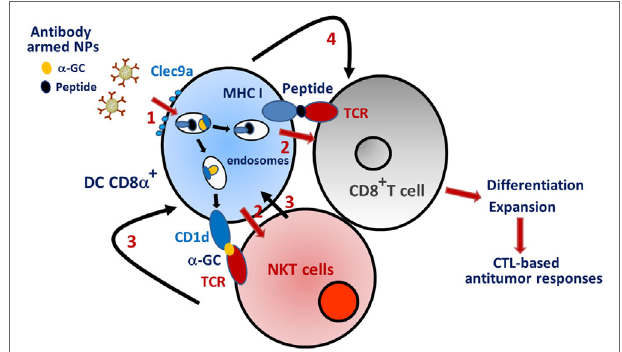
FiGURe 1 | Schematic “ménage à trois” between CD8 α + DC, natural killer T (NKT) cells, and naive CD8 + T cells. (1) Anti-Clec9a-armed nanoparticles that carry α -GalCer and tumor antigen are taken up by CD8 α + DC via the endocytic receptor Clec9a. (2) The active components are delivered in the endosomes and presented via MHC class I (peptide) and CD1d ( α -GalCer) to naïve CD8 + T cells and NKT cells, respectively. (3) In response to TCR triggering, NKT cells activate the maturation of CD8 α + dendritic cells (DCs) through cytokines and costimulatory (CD40) molecules. (4) Mature DCs transmit signals to naïve CD8 + T cells, which, in turn, differentiate into CTLs. (5) CTLs destroy tumor cells. Note that α -GalCer is acquired and presented by DCs that are also actively engaged in presenting peptides to T cells. This scheme does not consider reciprocal interactions between NKT cells and CD8 + T